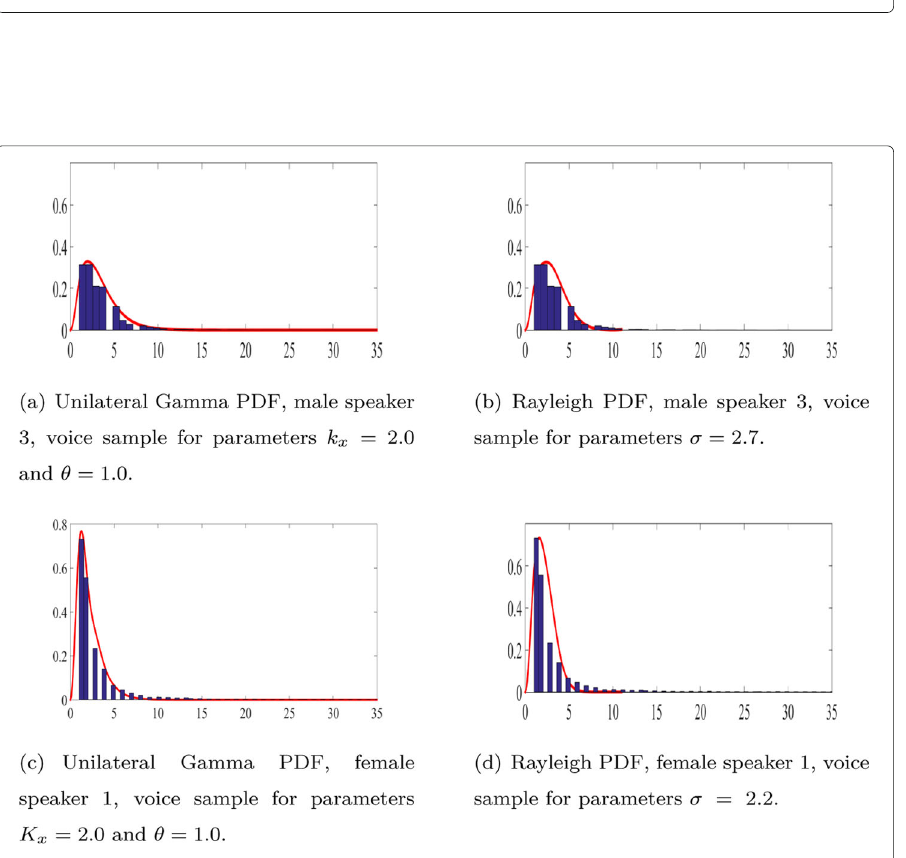
Fig. 3 PDF curves of Rayleigh and unilateral gamma distributions superimposed to histograms generated from voice samples of male and female